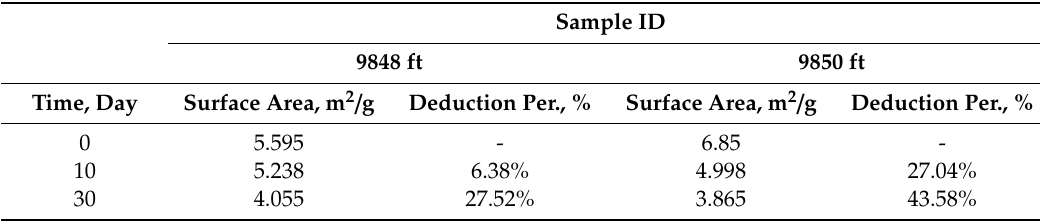
Figure 6. BET plot of 1 / [W((P 0 / P) − l)] versus P 0 / P. ( a ) sample at depth of 9848 ft; ( b ) sample at depth of 9850 ft. Table 2. Surface area vs. various Sc-CO 2 injection time.